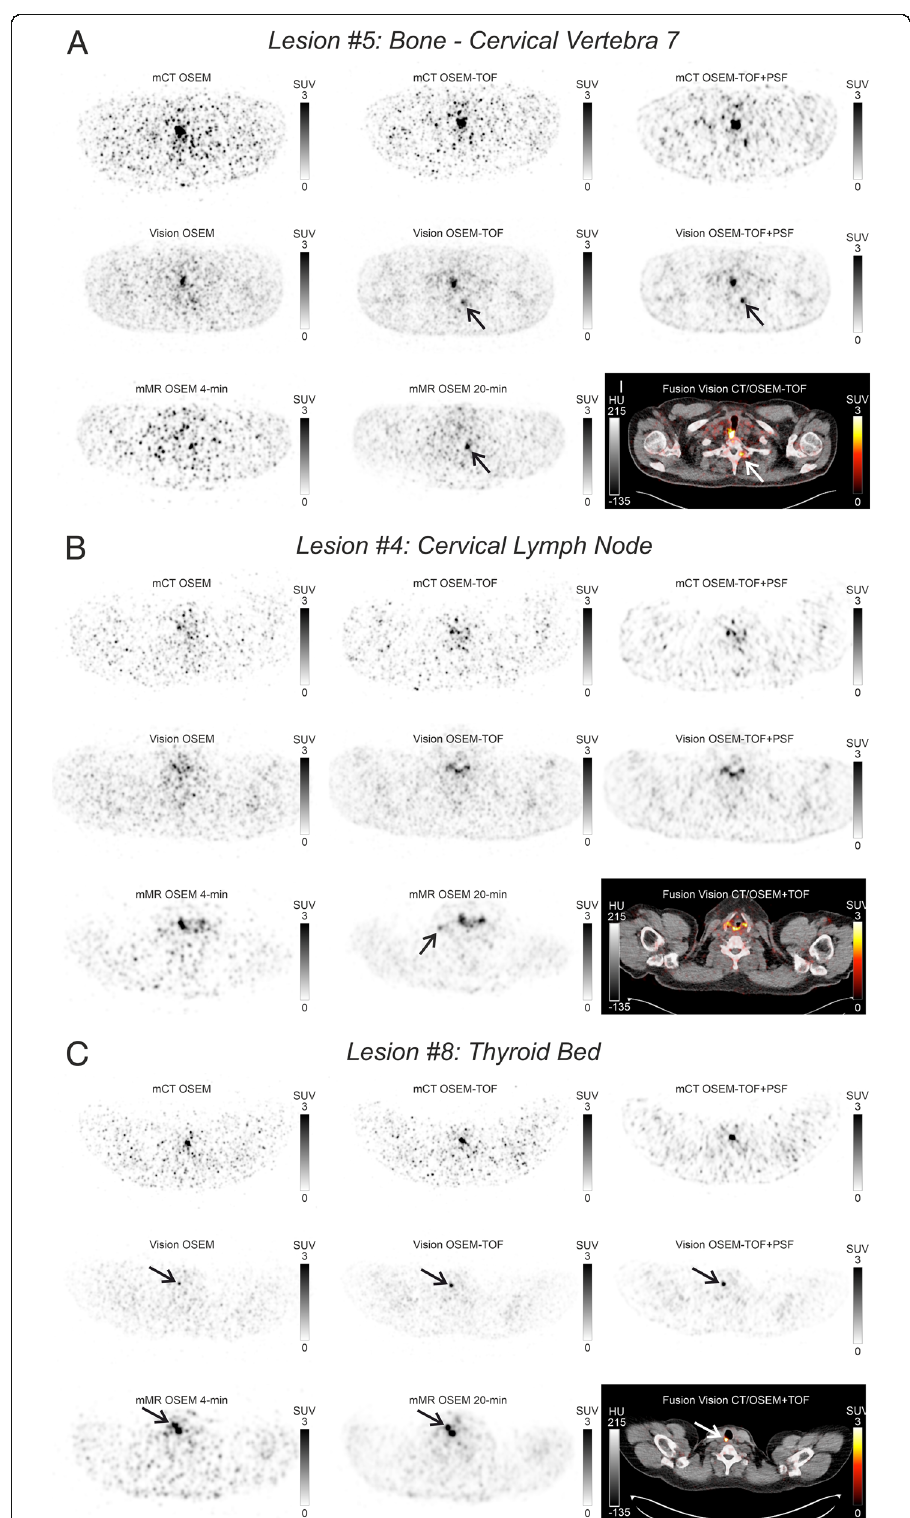
Fig. 2 PET(/CT) images of a an osteolytic lesion in cervical vertebra 7 (lesion #5), of b a cervical lymph node (lesion #4), and of c a thyroid bed lesion (lesion #8). Detected lesions are indicated by arrows. In a and c oesophageal tracer uptake is not visible on all images due to different imaging